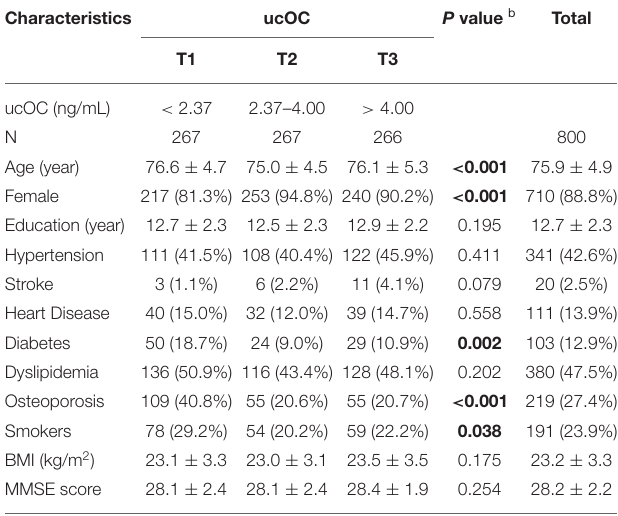
TABLE 1 | Characteristics of the study populations according to the levels of ucOC a